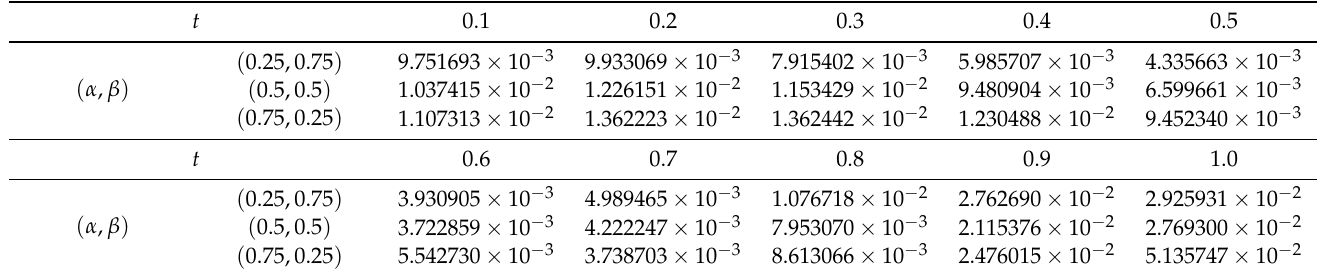
Table 2. Fractional equation of Example 1: maximum absolute error E ∞ at some time nodes, where ∆ t = 0.01, ( α , β ) is fixed to be ( 0.25,0.75 ) , ( 0.5,0.5 ) , and ( 0.75,0.25 ) in turn, and noisy data are